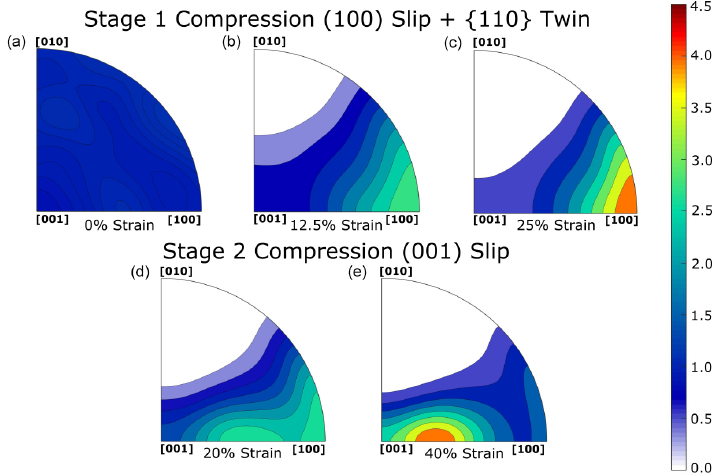
Figure 6. Inverse pole figures (a, b, c) of first stage compression in VPSC simulation starting from a random texture at 0% strain to 25% strain dominated by slip along (100) planes with significant contribution of { 110 } twins. Second stage of deformation (d, e) starting from (c) , allowing 20% and 40% strain with deformation dominated by (001)